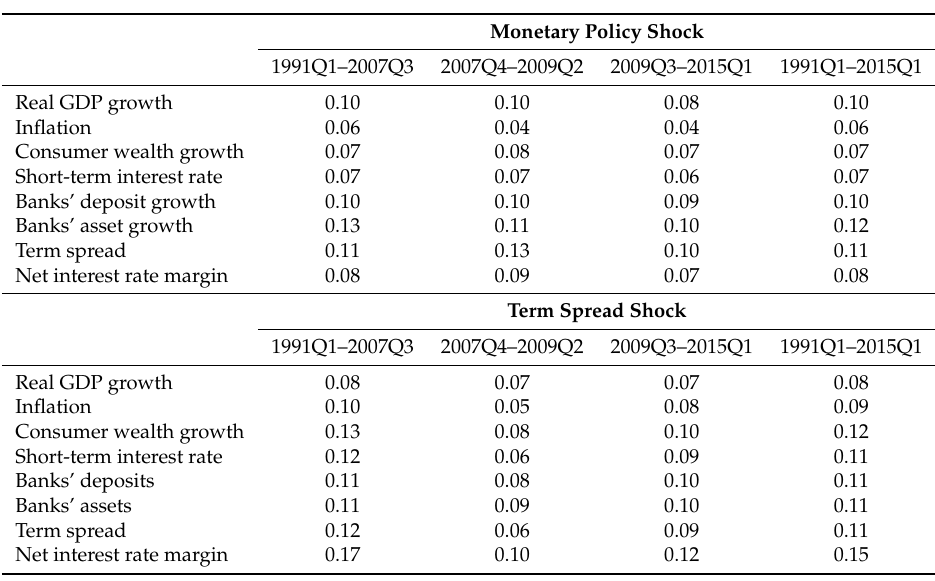
Table 2. Forecast error variance